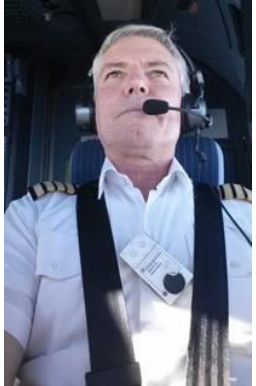
Figure 1. Pilot wearing a dosimeter during a flight.